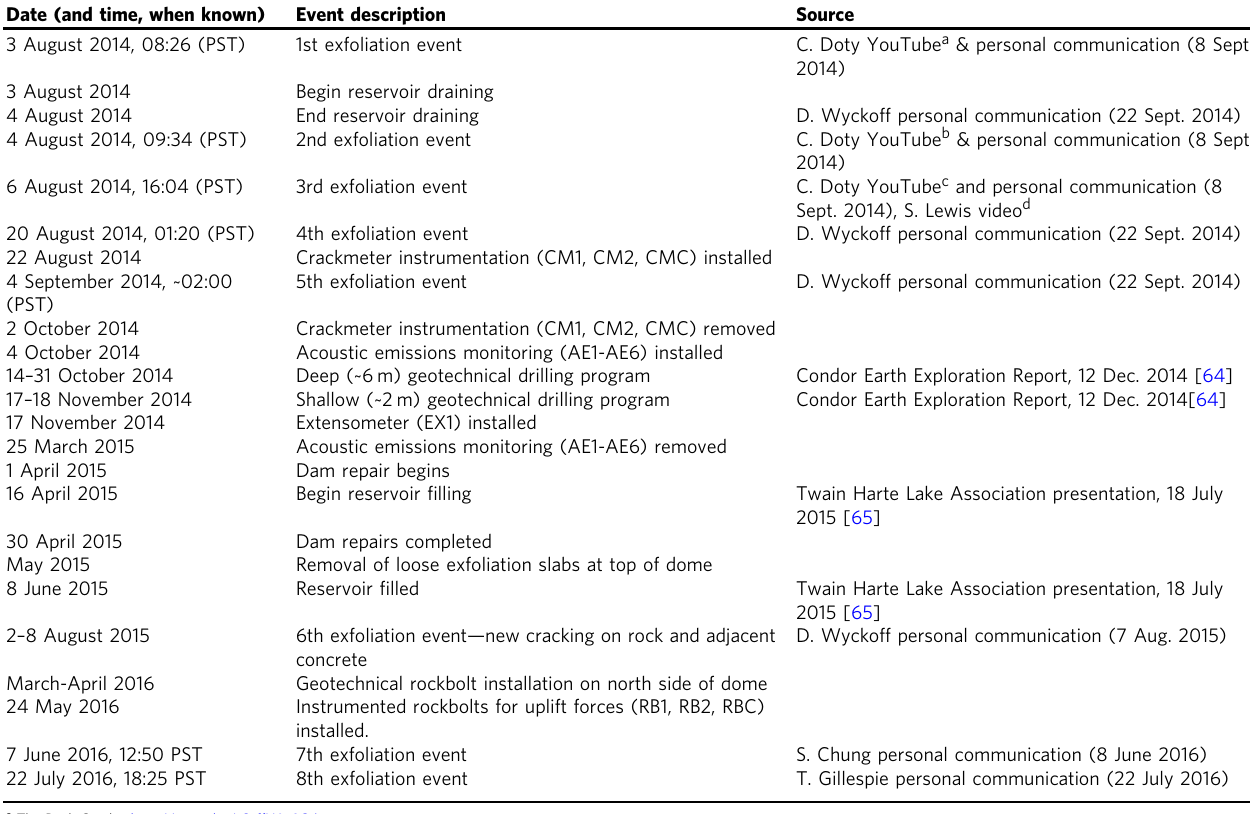
Table 1 Event sequence at Twain Harte Dome from 2014 through